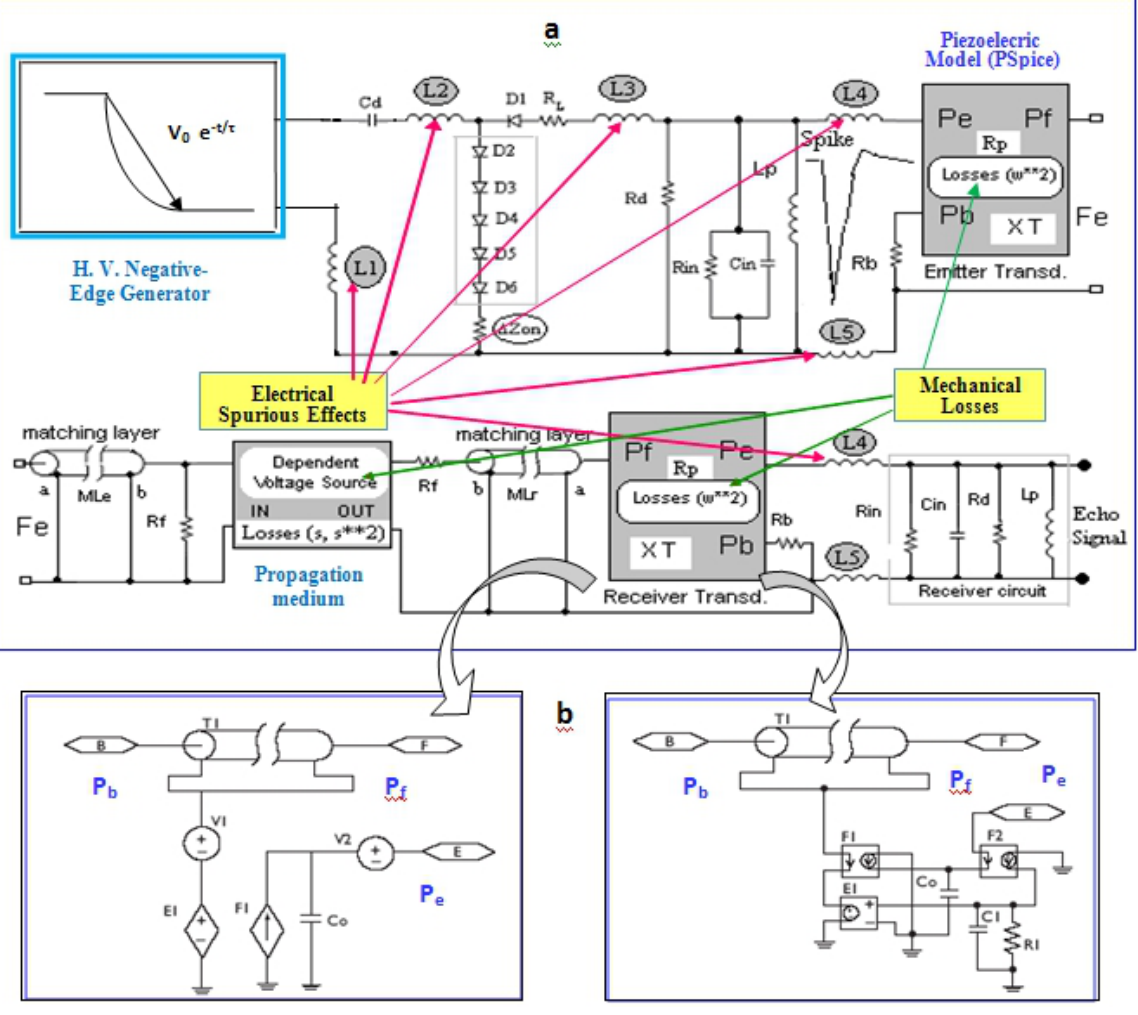
Figure 3. ( a ) Global equivalent circuit modeling for two-way piezoelectric transducer systems, including mechanical losses and ultrasonic & electronic spurious